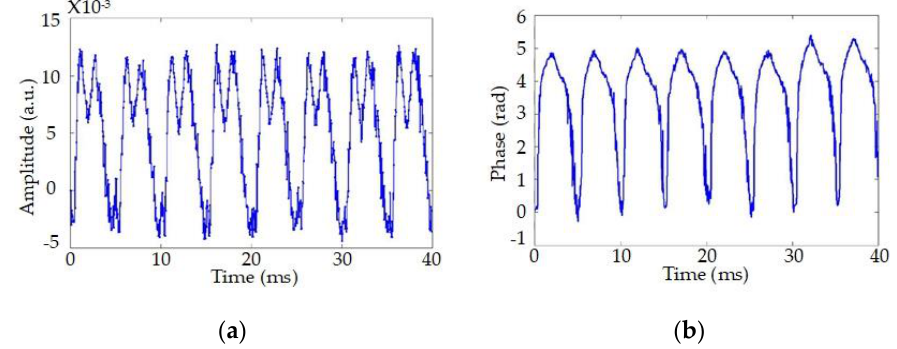
Figure 3. The demodulation results of ( a ) amplitude and ( b ) phase in time domain. Reproduced from our previous paper